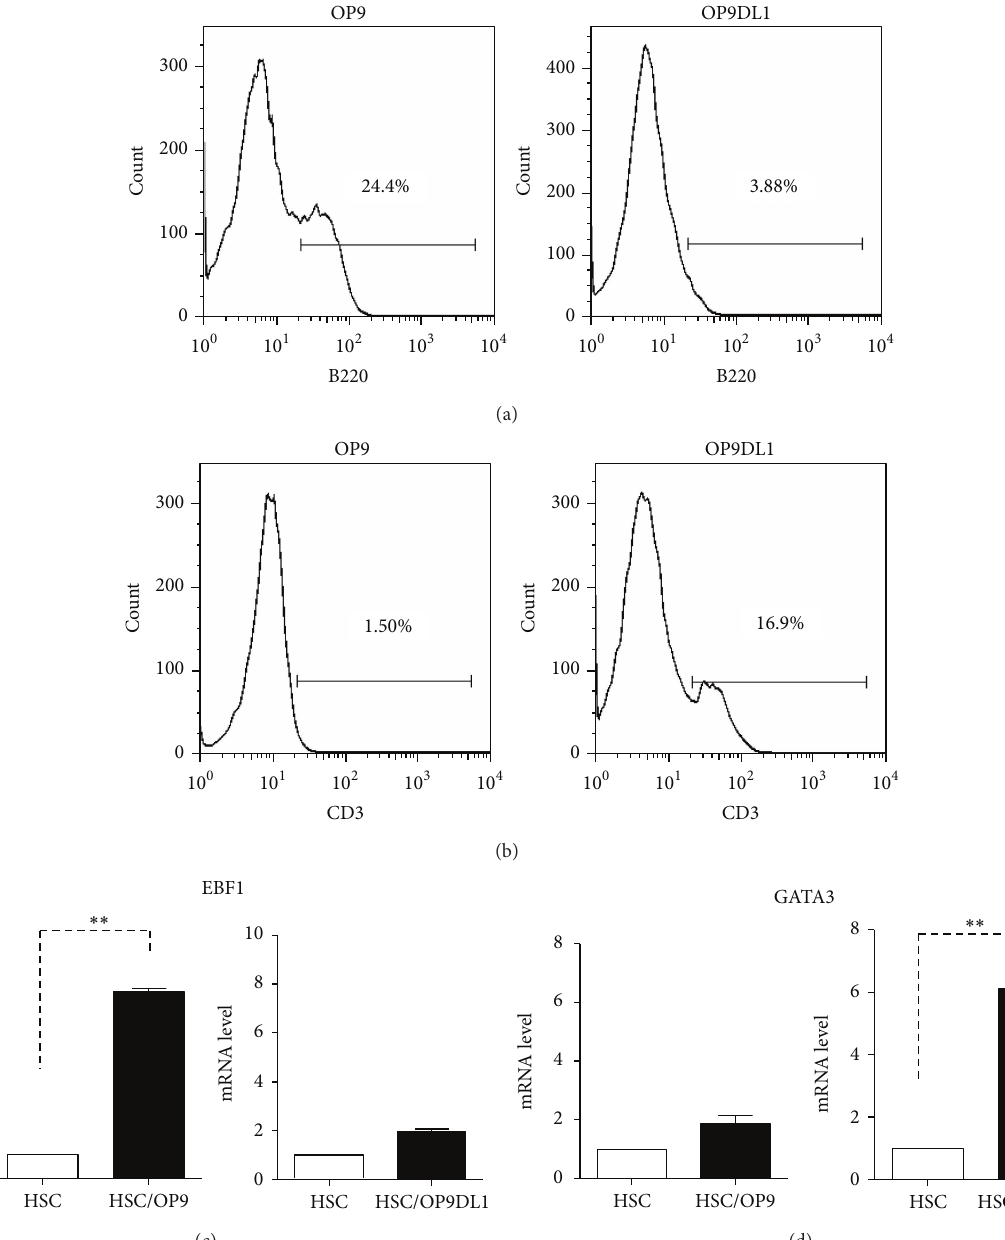
Figure 3: Effect of OP9 or OP9DL1 on differentiation of bone marrow CD34 + cells. OP9 or OP9DL1 cells (5 × 10 4 /well) were plated in 12-well plates with 𝛼 -MEM medium plus 20% FBS 12h prior to the addition of BM CD34 + (5 × 10 5 /well). The coculture was started with 𝛼 -MEM medium plus 20% FBS containing a final concentration of 5 ng/mL each of IL-7 and Flt-3 ligand (Flt-3L). 12 days later, cells were collected for FACS analysis ((a) and (b)), and EBF1 or GATA3 gene expression was determined by real-time PCR after 5-day coculture, respectively ((c) and (d)). (Error bars present the SD of the mean values, ∗∗ 𝑃 < 0.01